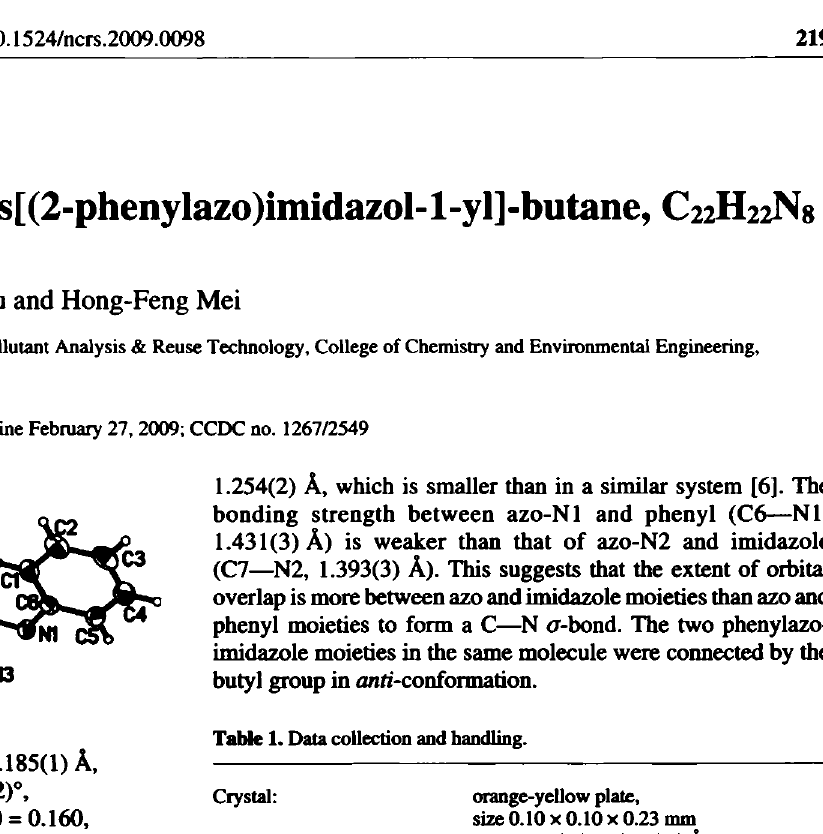
Table 1. Data collection and handling.